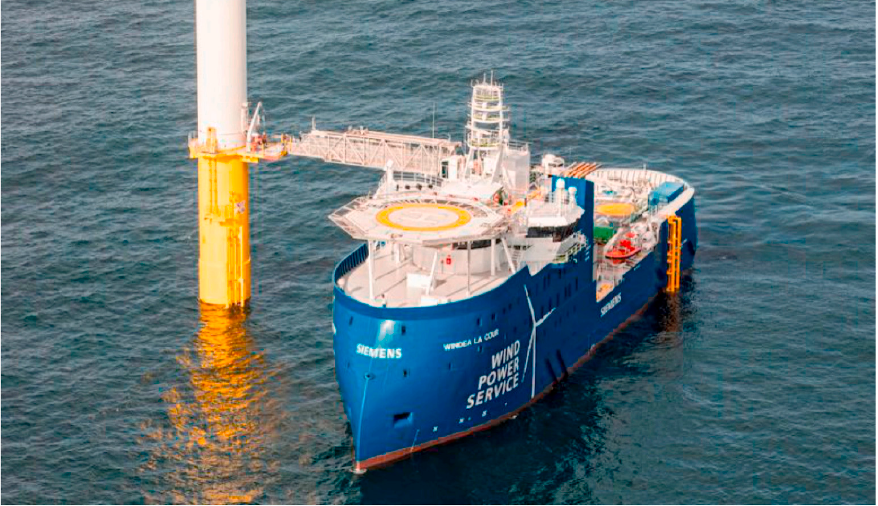
Figure 3. Operation and maintenance of traffic vessels